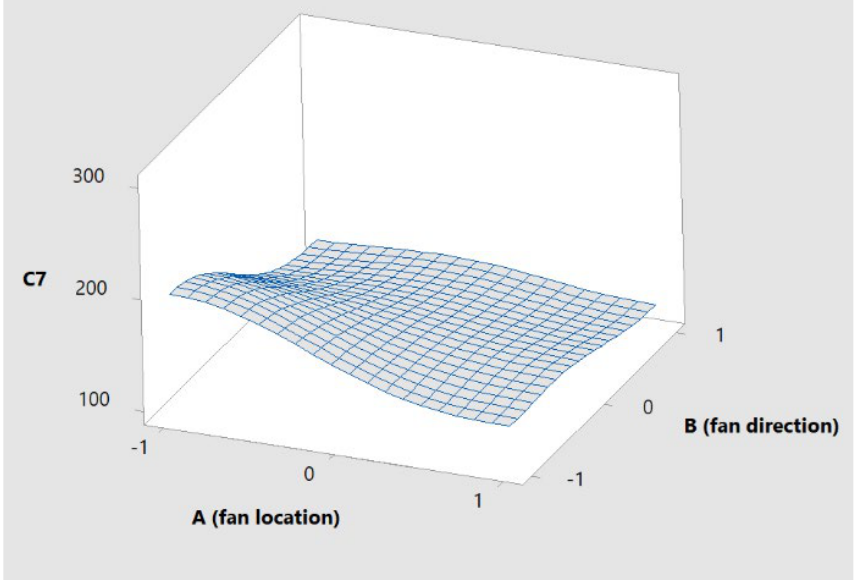
Figure 7. Surface plot of cooling time versus fan direction and fan location (C7: cooling time in minutes).